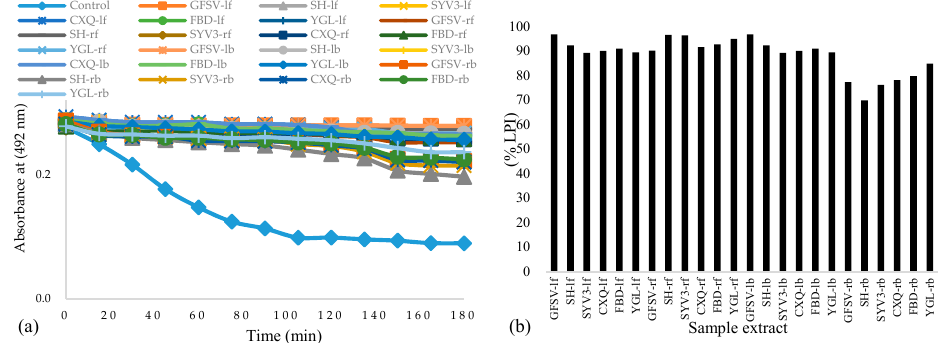
Figure 1. Antioxidant activity of the extracts measured by β -carotene bleaching method ( a ) and their lipid peroxidation inhibition (% LPI) ( b ). Notes: lf-leaves free phenolics; rf-roots free phenolics; lb-leaves conjugate phenolics; rb-roots conjugate phenolics.